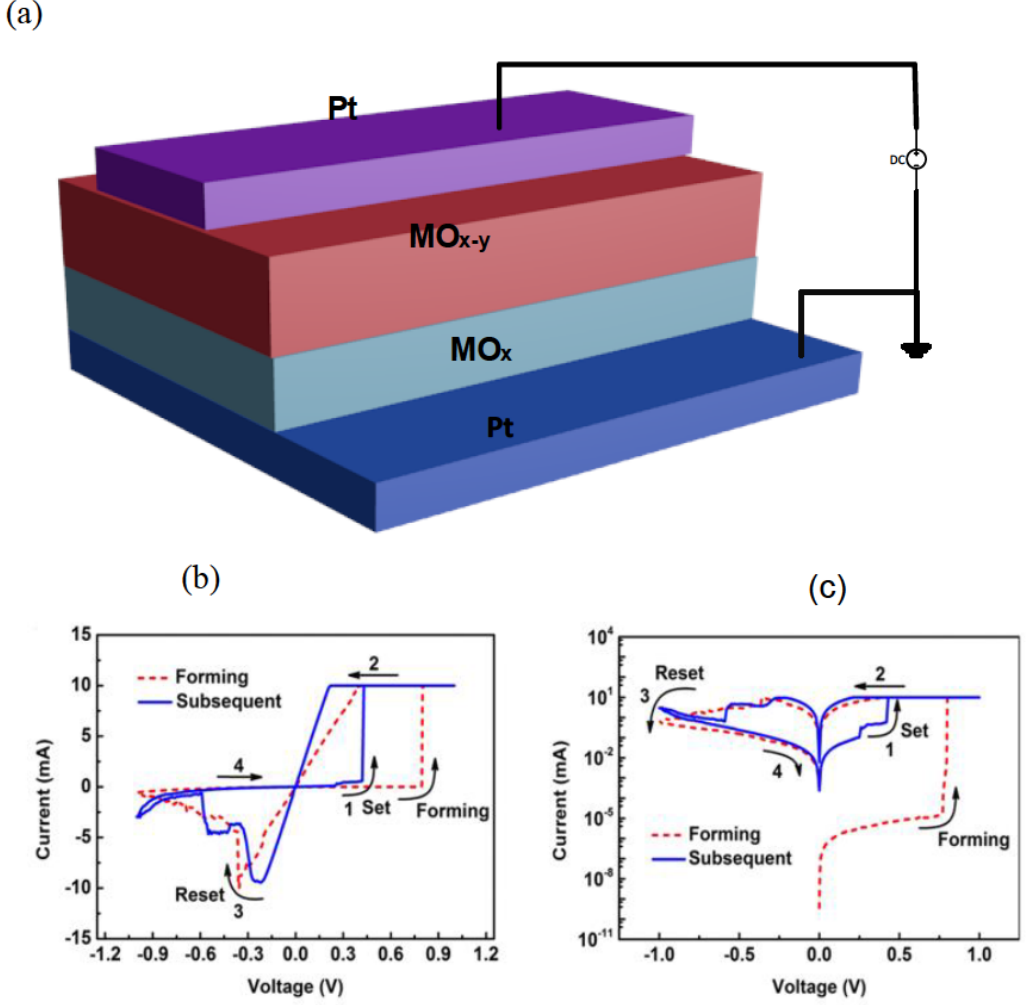
Figure 1: (a) General 3-D Bilayer stack structure of Memristor, Initial electroforming and the typical subsequent quasi-static I-V cycles for the Ag/a-LSMO/Pt memristor cells with a Compliance current of 10mA shown on (b) linear scale and (c) semilogarithmic scale. Reprinted with permission from D. Liu, H. Cheng, X. Zhu, G. Wang and N. Wang // ACS Appl.Mater. Interfaces 5 (2013)11258, (C) 2013 American Chemical